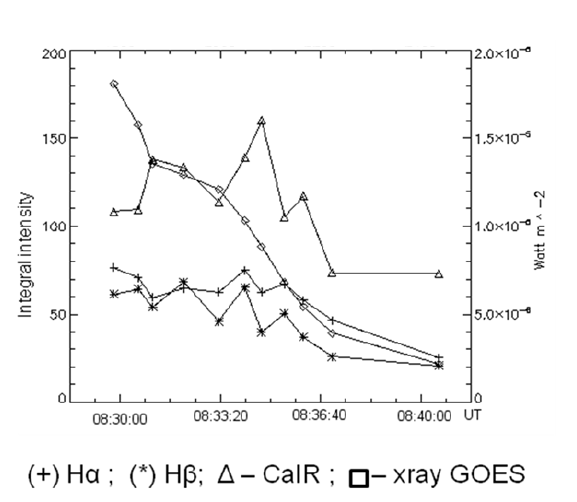
Figure 1. Flare 2012-11-24, 13:24:15 UT, from left to right: SJ, H α , Ca 8542 Å.